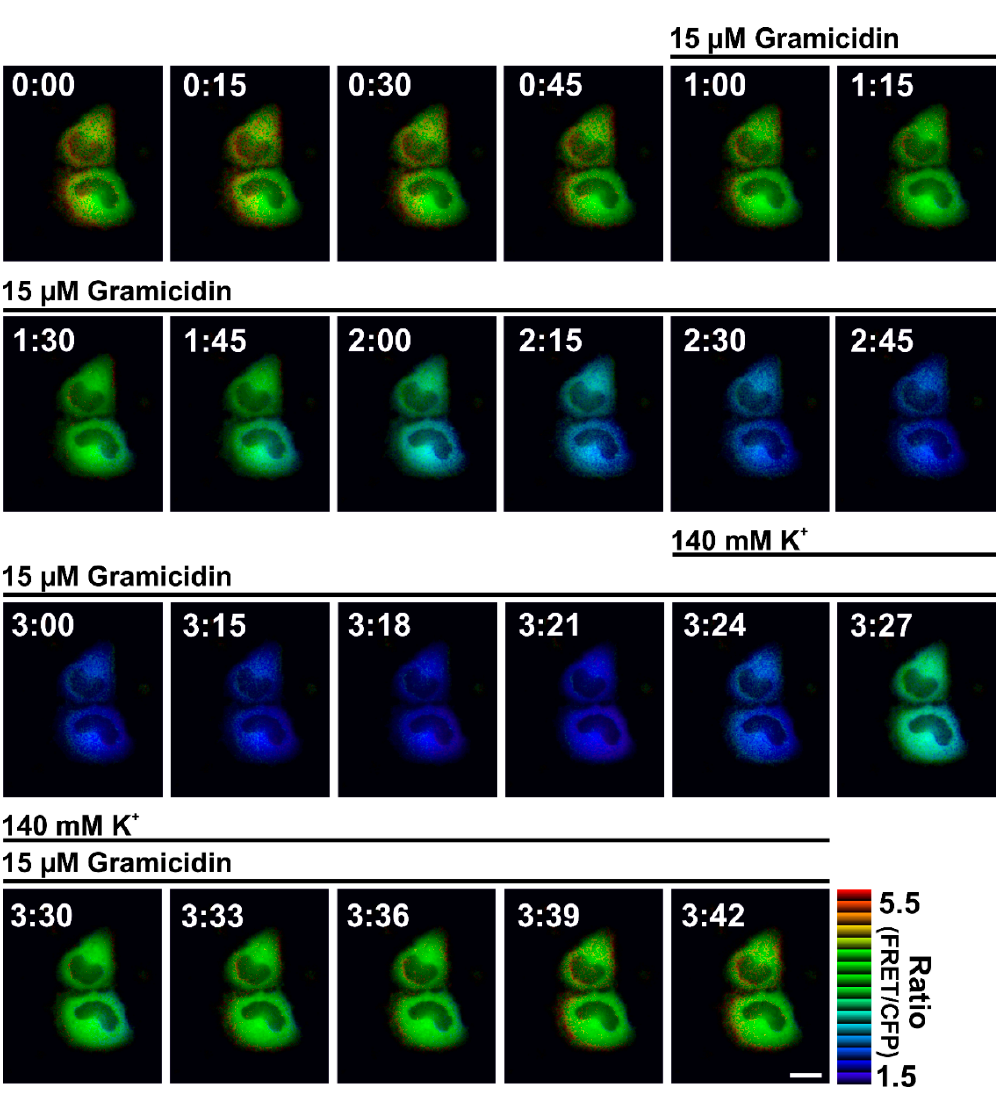
Figure 3. Pseudo-colored ratio images over time of HeLa cells expressing GEPII 1.0, a FRET-based K + sensor. Pseudo-colored ratio images of HeLa cells expressing NES-GEPII 1.0 were treated with 15 µM gramicidin, a K + selective channel forming peptide, in the absence or presence of 140 mM extracellular K + as indicated. White numbers in the images represent the time in min:sec of image acquisition. Scale bar in the right lower image represents 10 µM.